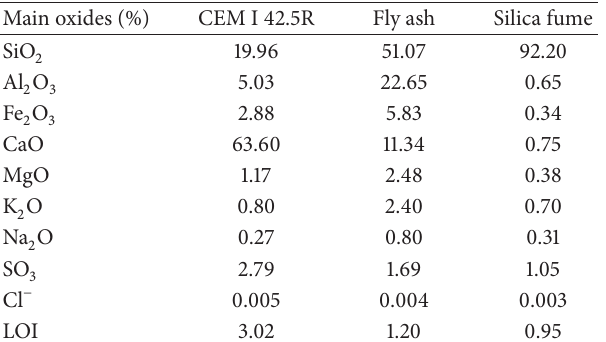
Table 1: Chemical composition of